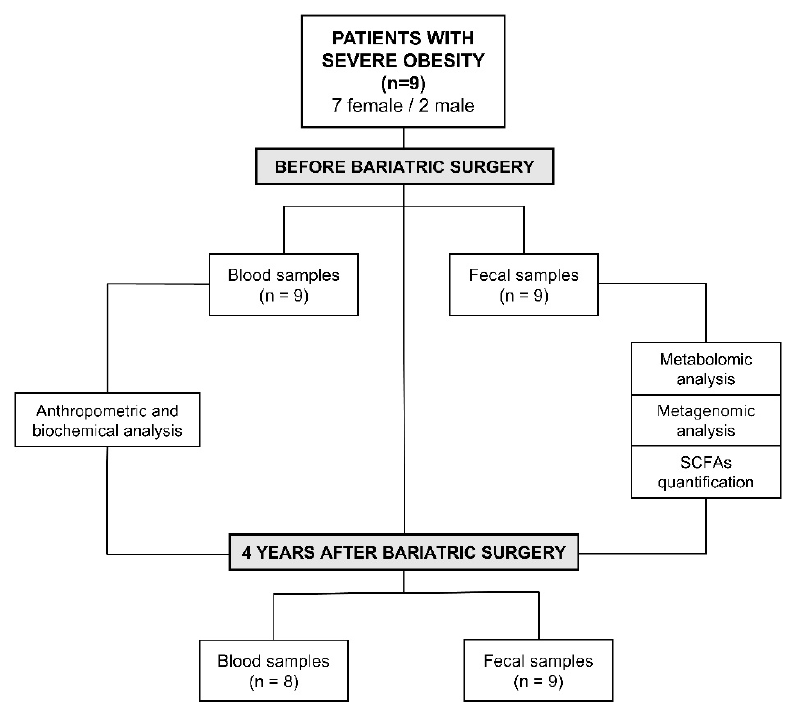
Figure 1. Experimental design and characteristics of the patients included in the